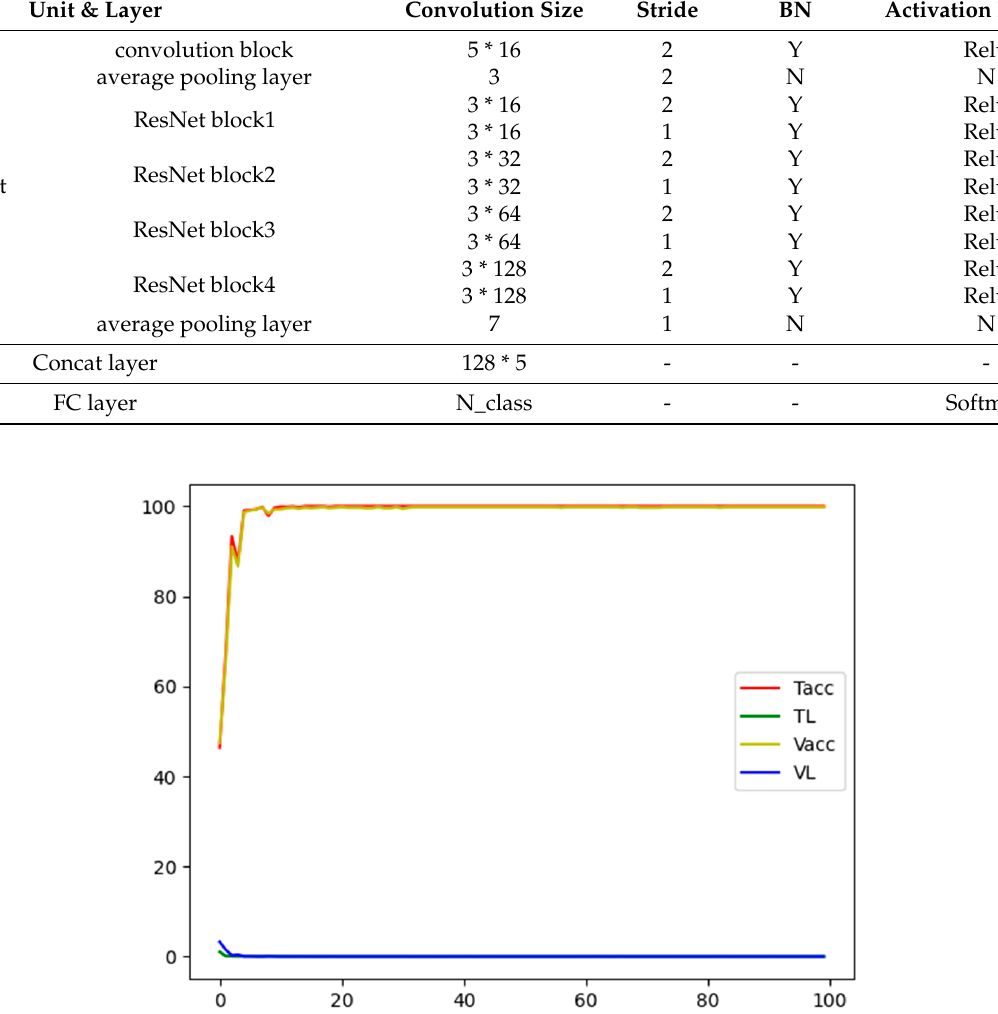
Figure 12. Multi-input ResNet model training process.